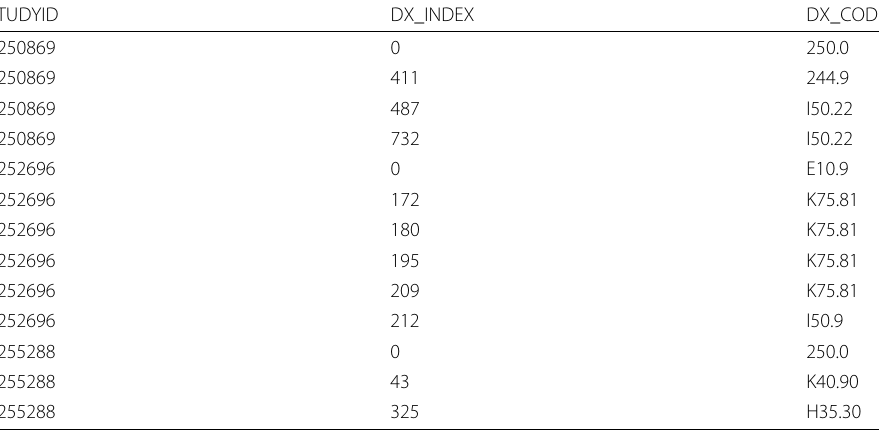
Table 2 Diagnosis file - this file contains information regarding ICD codes that went along with